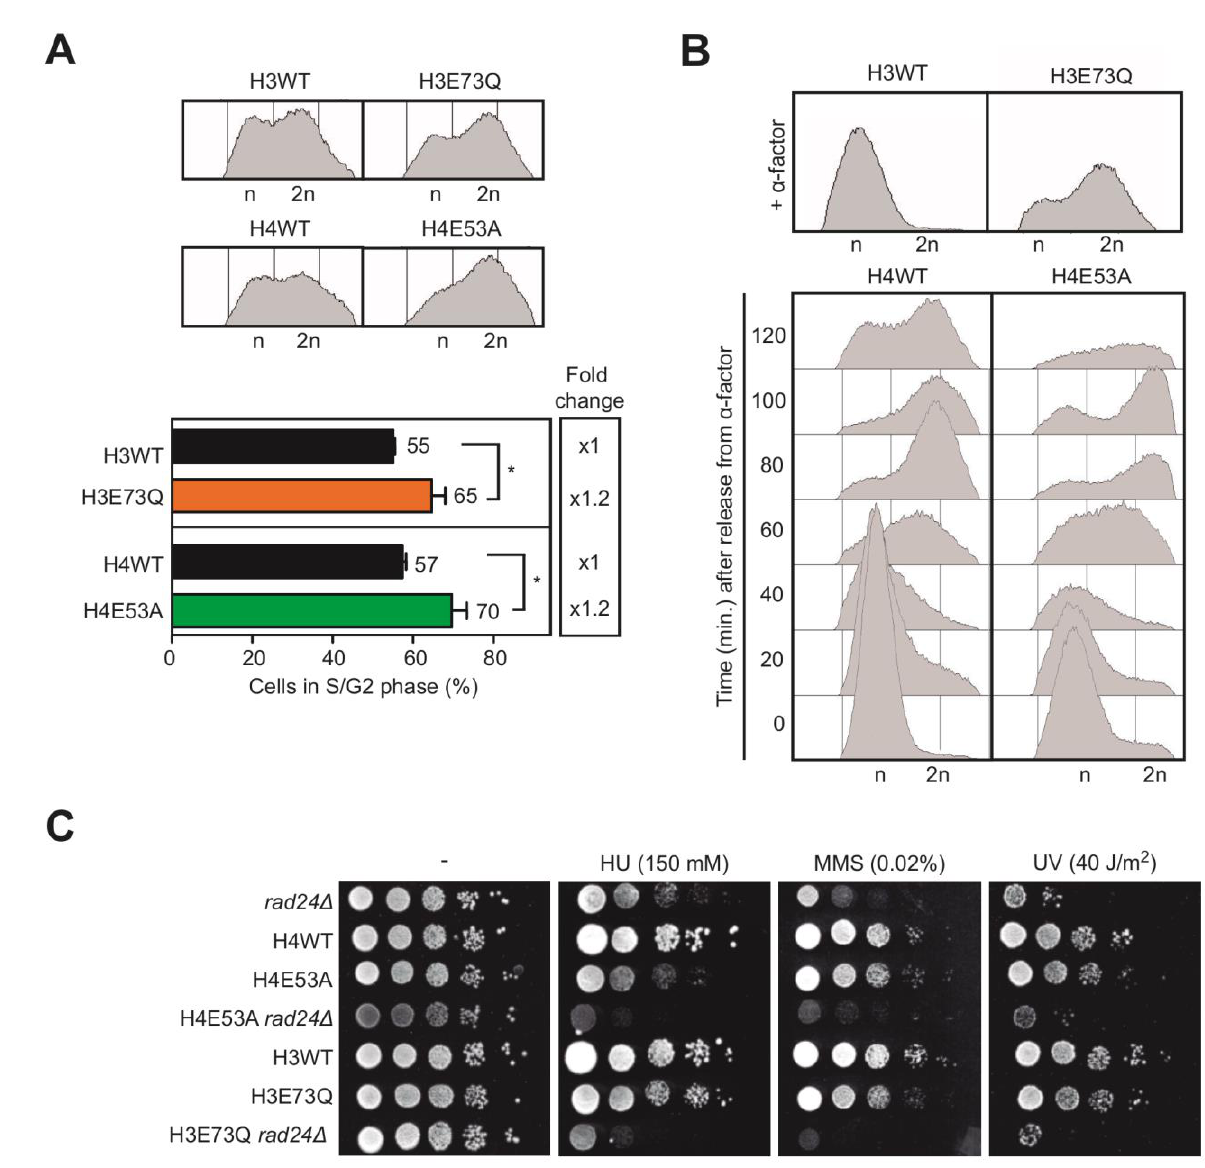
FIGURE 4: Histone H3E73Q and H4E53A mutants increase replication stress. (A) Analysis and quantification of cell cycle phases in asynchro- nous cultures of H3 wild-type (H3WT), H3E73Q (H3E73Q) , H4 wild-type (H4WT) and H4E53A (H4E53A) strains by FACS (n=3). (B) Analysis of cell cycle progression in H3 wild-type (H3WT), H3E73Q (H3E73Q) , H4 wild-type (H4WT) and H4E53A (H4E53A) strains by FACS. (C) Sensitivity to HU (150 mM), MMS (0.02%), UV (40 J/m 2 ) of rad24 (R24), H3 wild-type (H3WTn), H3E73Q (H3E73Qn) , H3E73Q rad24 (E73QR24), H4 wild-type (H4WTn), H4E53A (H4E53An) and H3E73Q rad24 (E53AR24) strains coming from a crossing H3E73Q and H4E53A with W303-1B rad24 Δ . Similar results were obtained with different spores from the same genetic cross. Means and SEM are plotted in (A). *p ≤ 0.05. (two- tailed Student’s t